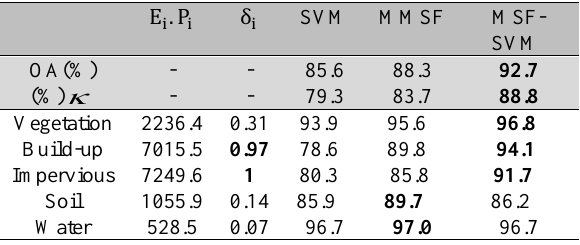
Table 2. The SVM assessment parameters and the classification accuracies obtained on the Berlin dataset